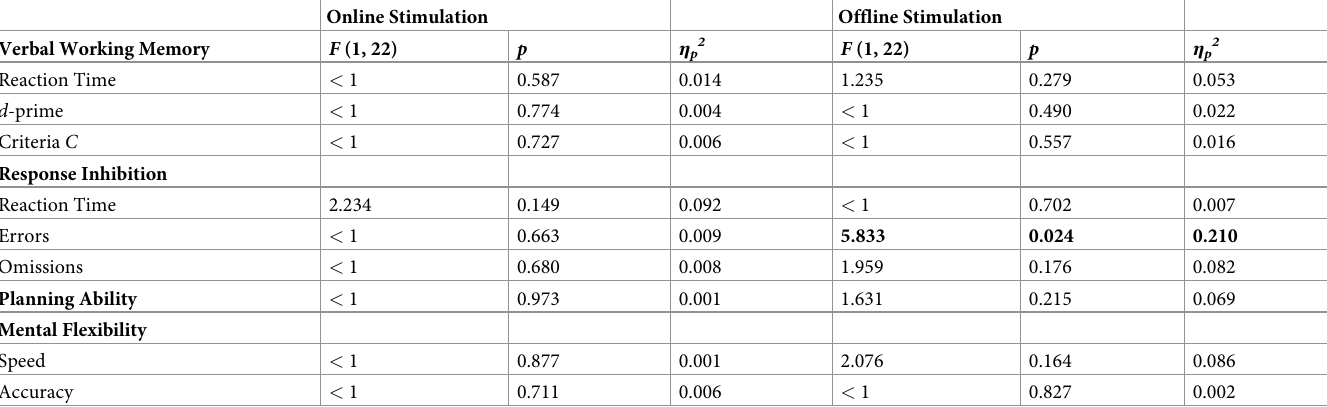
Table 4. Interaction effects TIME � GROUP of different neuropsychological performance measures during “online” vs. “offline”